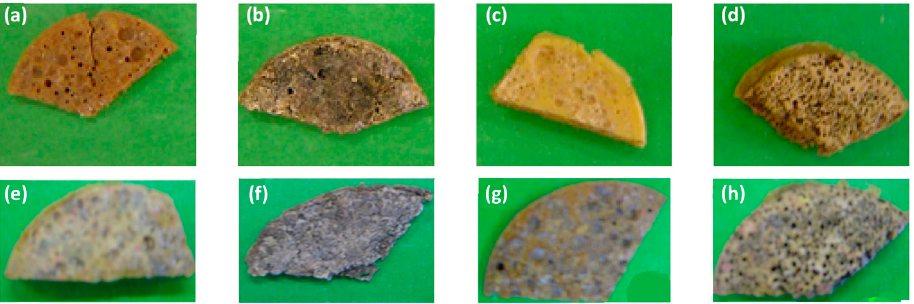
Figure 4 . Digital images of PUs after soil degradation: ( a ) PULOB, ( b ) PULOA, ( c ) PUPFOB, ( d ) PUPFOA after 40 days; and ( e ) PULOB, ( f ) PULOA, ( g ) PUPFOB, ( h ) PUPFOA after 120